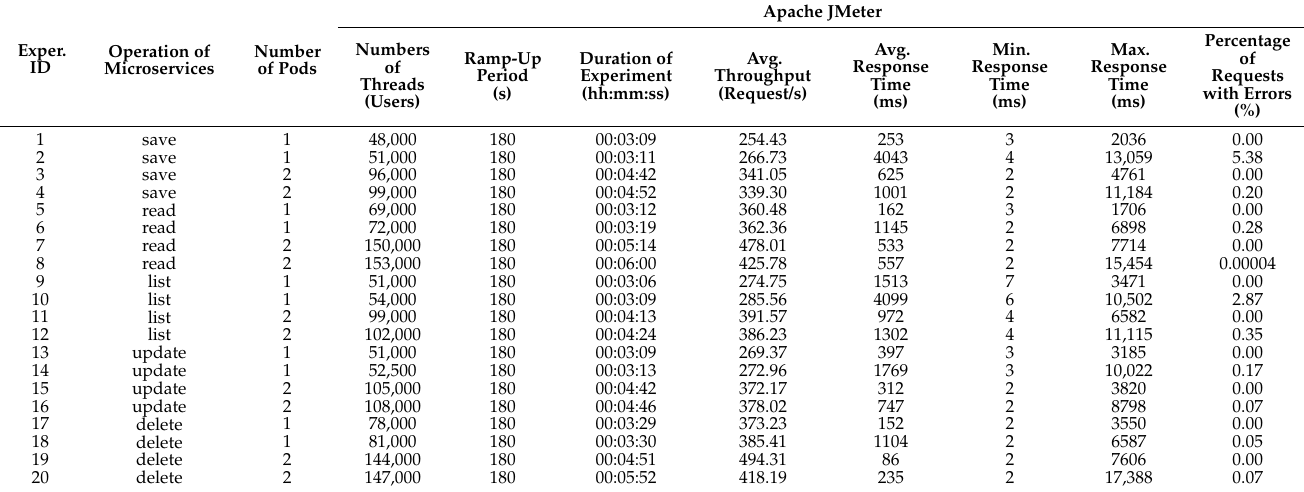
Table 3. Information on the experiments carried out with the system’s